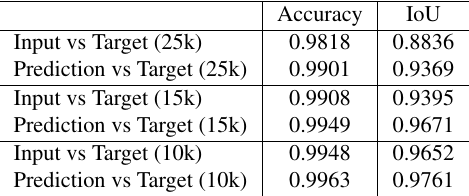
Table 3. Comparison with skip connections and data augmentation with